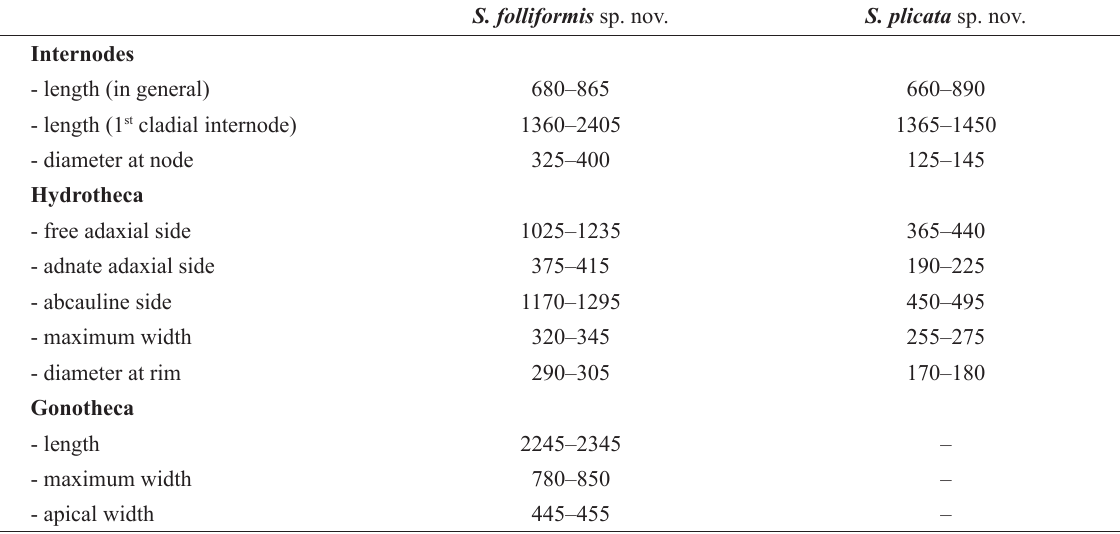
Table 3. Measurements (in µm) of Sertularella folliformis sp. nov. and S. plicata sp.